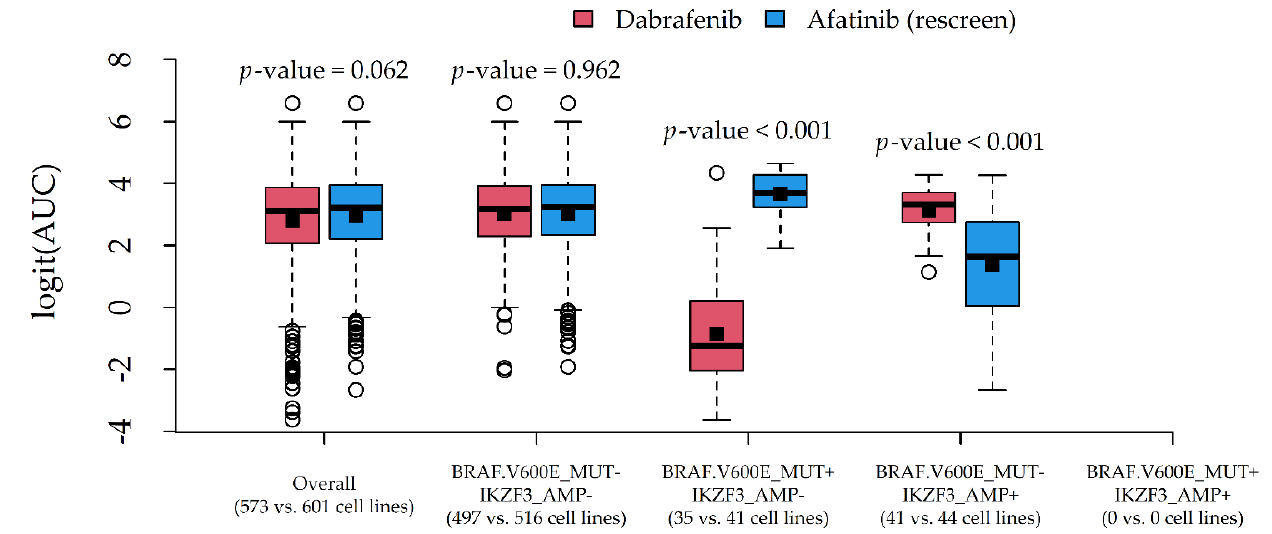
Figure 6. Graphical inspection of a drug-gene interaction involving the two compounds Dabrafenib and Afatinib (rescreen), and the two alterations BRAF.V600E_MUT and IKZF3_AMP. Boxplots represent the median (central line), the mean (square), 25th – 75th percentiles (box), and min-max non-outlier values (whiskers); p -values are from the t -test.